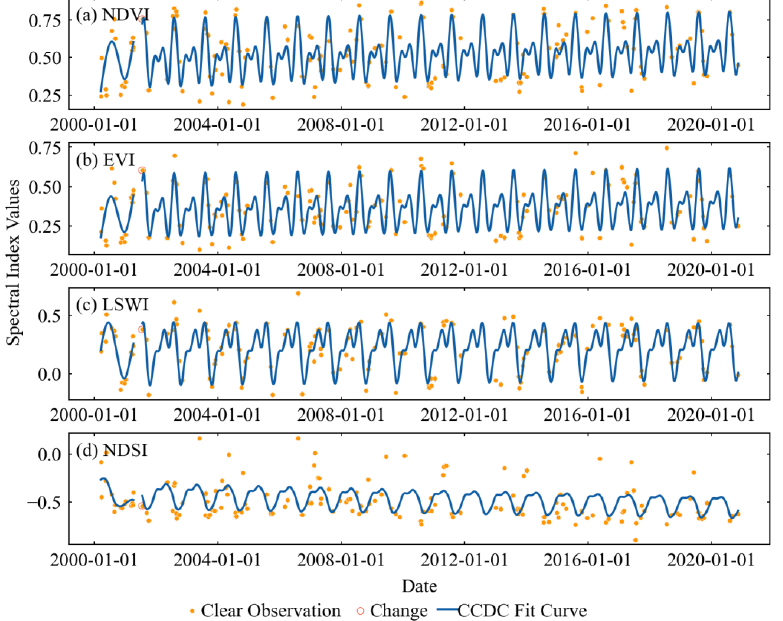
Figure 4. Example (longitude: 108.63134233°E, latitude: 27.46887562°N) of CCDC-algorithm-based model fit of ( a ) NDVI, ( b ) EVI, ( c ) LSWI, and ( d ) NDSI.